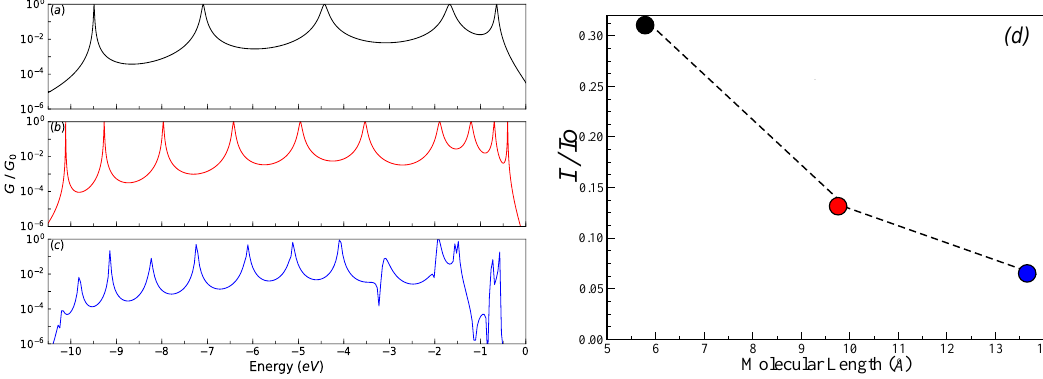
Figure 5. (color online) Normalized conductance ( G / G 0 ) for ( a ) one ring; ( b ) two rings; and ( c ) three rings as function of energy; ( d ) presents the current (I) as a function of molecular length. Calculations are for E c = − 5.54 eV, E s = 0.98 eV, t d = t δ = t c = − 2.40 eV, t τ = t s = − 0.83 eV, and Γ = 5.32